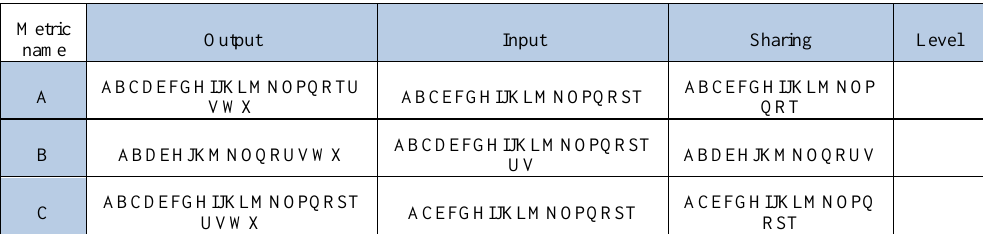
Table 4. level 1